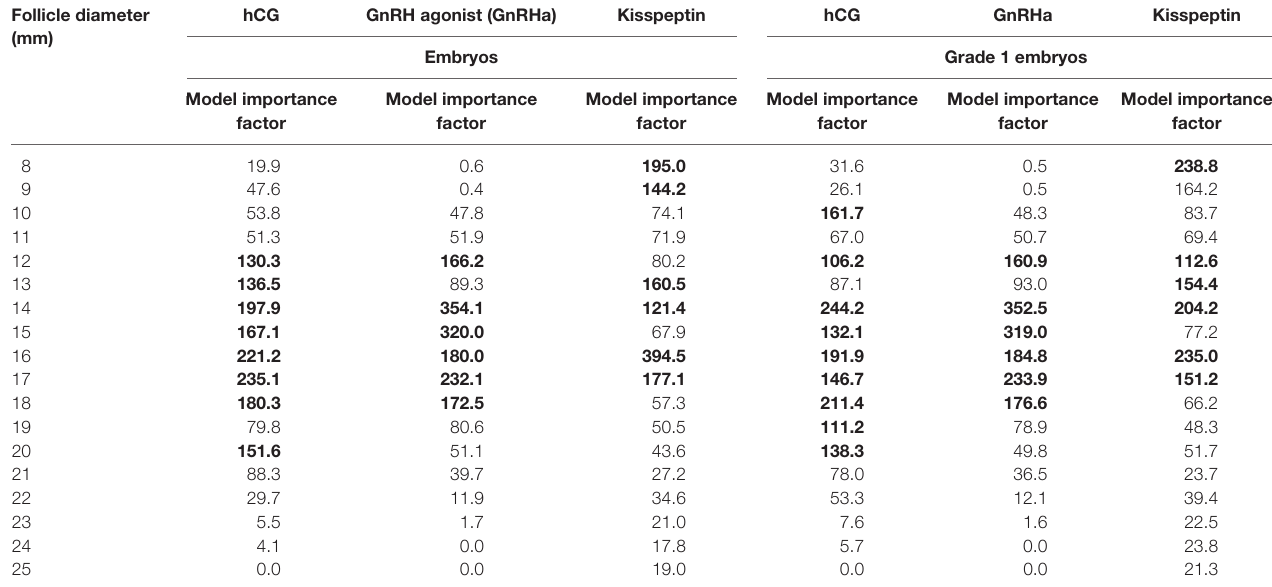
Table 5 | Model importance factors (random forest) for follicle diameter in determining number of embryos and number of high quality embryos.